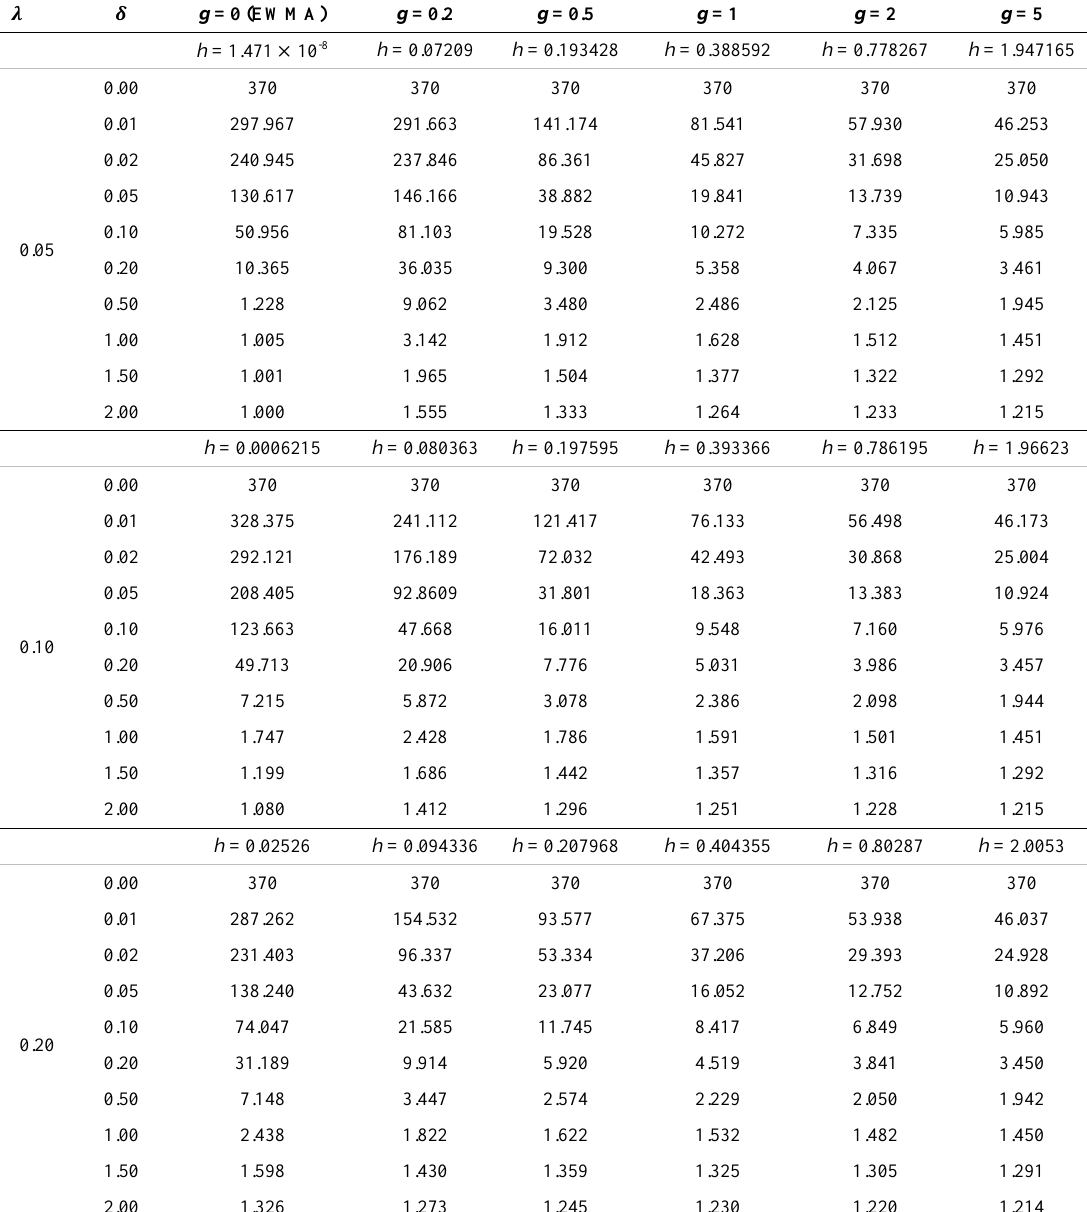
Table 2. Compare the modified EWMA chart on the IMA (2,1) model at various λ and g given 𝜽 = 0.05 and l = 0